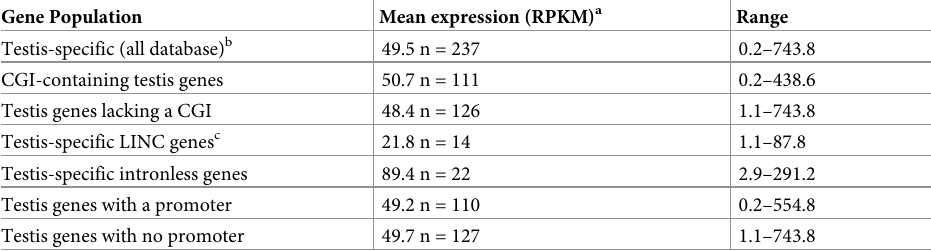
Table 2. Expression level of testis-specific gene